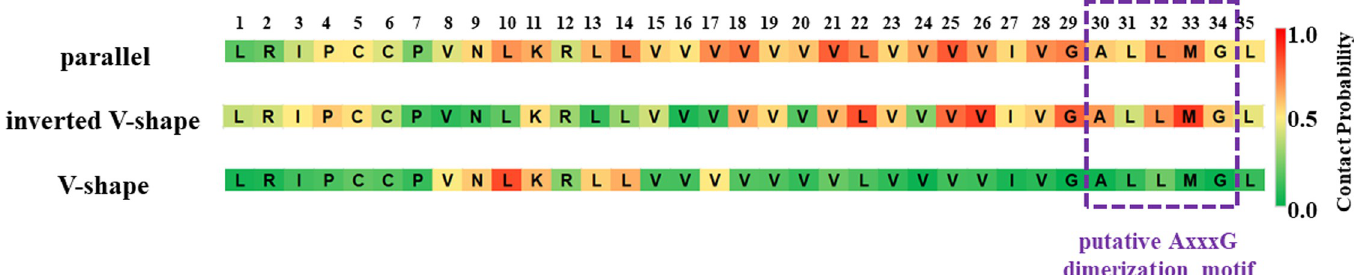
Fig 8. Contact probabilities of SP-C residues for all dimer topologies identified in this study. The purple dashed line depicts the position of the putative AxxxG motif as reported by Kairys et al . [23].